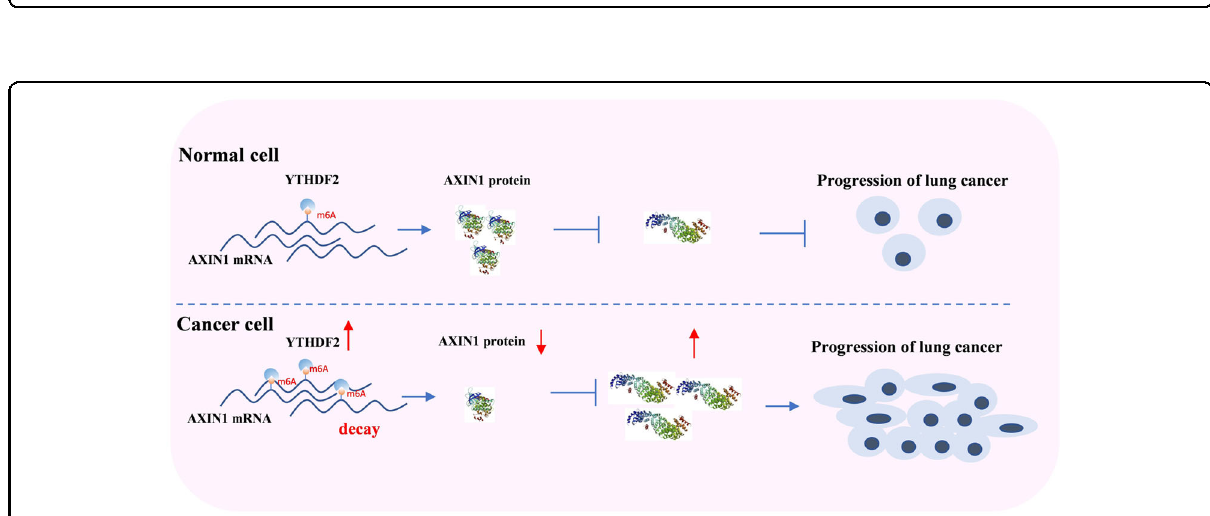
Fig. 7 YTHDF2 high expressed promoted progression and metastasis of lung cancer cells via AXIN1/Wnt/ β -catenin signalling. YTHDF2 facilitated the decay of AXIN1 m6A mRNA and results in the dereased AXIN1protein level.The decreased AXIN1 promote the activity of Wnt/ β -catenin signalling and enhance the proliferation and migration of lung